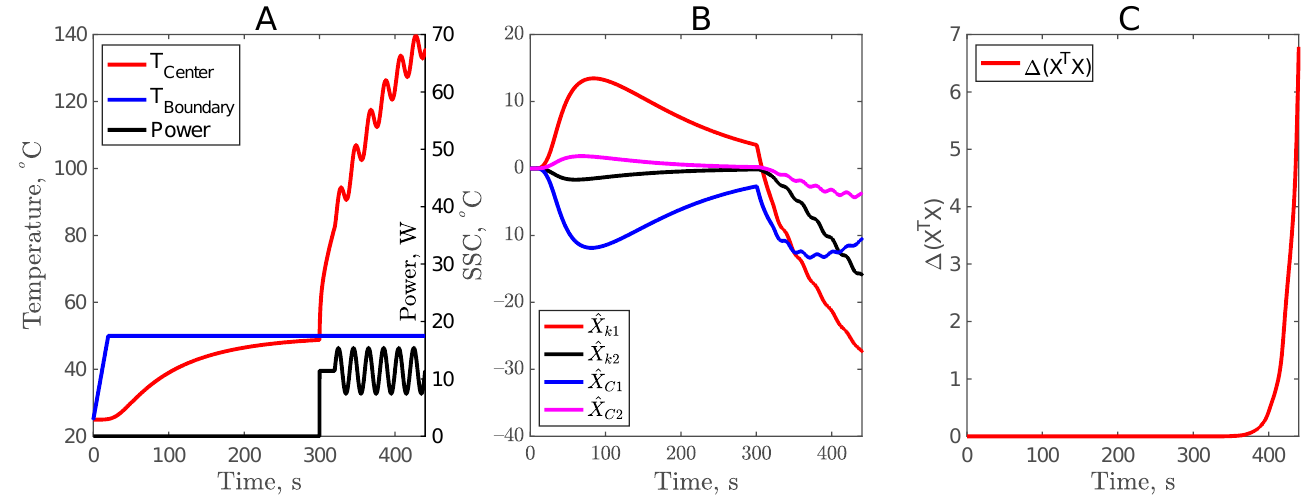
Figure 5. Center temperature profile with power input ( A ), scaled sensitivity coefficients ( B ), and criteria for optimal design ( C ) for sinusoidal center heater power profile.